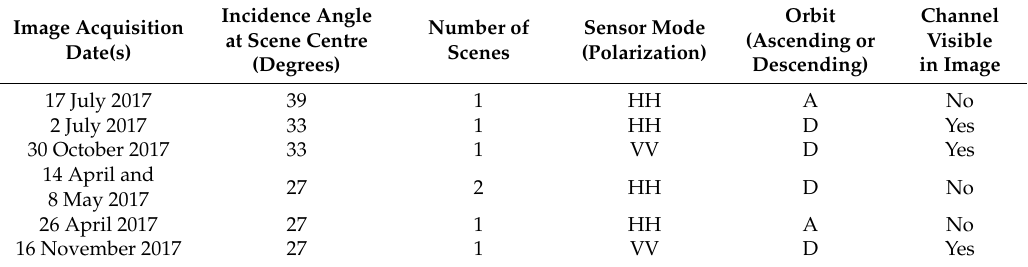
Table 2. Product Specifications of RADARSAT-2 acquisitions (Canadian Space Agency (CSA)) used in the analysis. All scenes were acquired in the Ultrafine mode, right looking, with a range and azimuth resolution of 1.3 m × 2.1 m, resulting in a processed pixel spacing of 2.1 m–2.95 m (dependent on the incidence